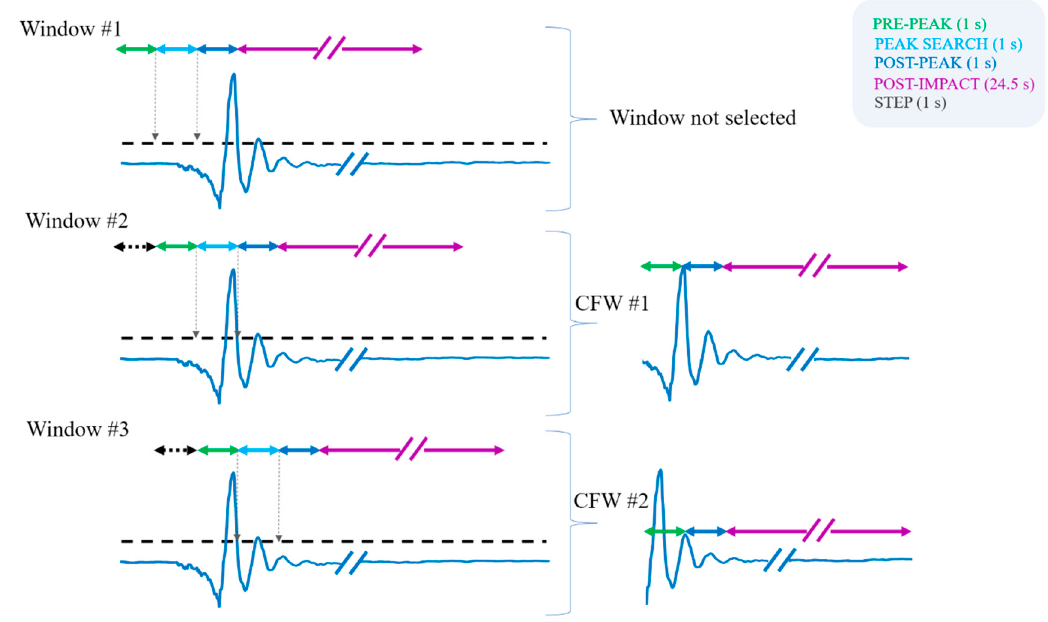
Figure 1. The windowing procedure is applied to a representative acceleration norm signal. The dashed line represents the 1.4 g threshold. Three consecutive windows are shown and analyzed. The first window is not selected, since no peaks are detected in the peak “search” interval. Windows #2 and #3 are instead two possible candidate fall windows (CFWs), and are then passed to the next steps for feature extraction and classification.